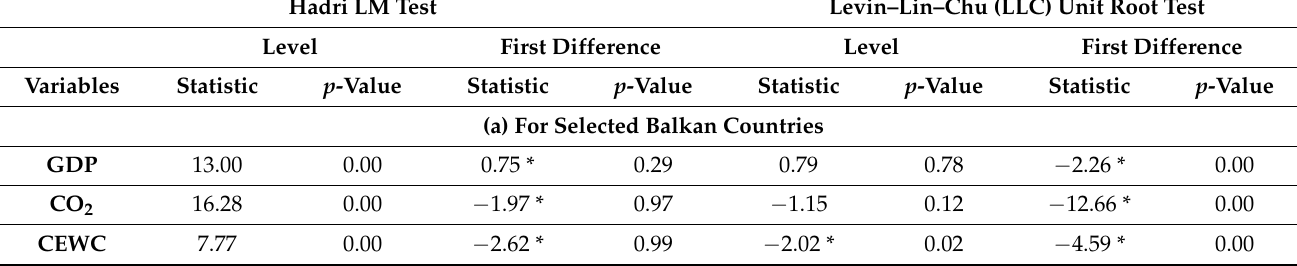
Table 3. Results of stationary